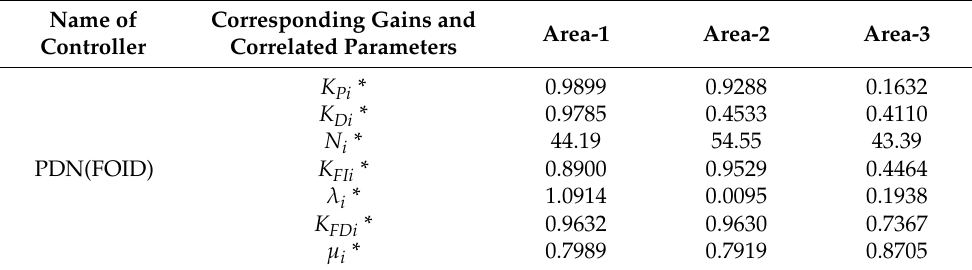
Table 9. Finest values of gains and related parameters of PDN(FOID) controllers for scheme-6 (thermal–bio-diesel–GPP-Ss (GT) system including WavePPt, PV, and C ES with duple compensation) (* Signify optimum values).